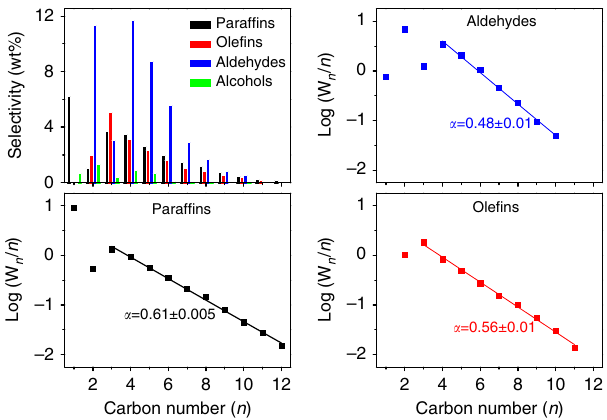
Figure 2 | Products chain lengthening. Detailed selectivity patterns and Anderson–Schulz–Flory (ASF) chain-lengthening characteristics of the various product classes over Co 4 Mn 1 K 0.1 at 220 (cid:2) C. An ASF plot for alcohols could not be constructed because of the low fractions of alcohols versus